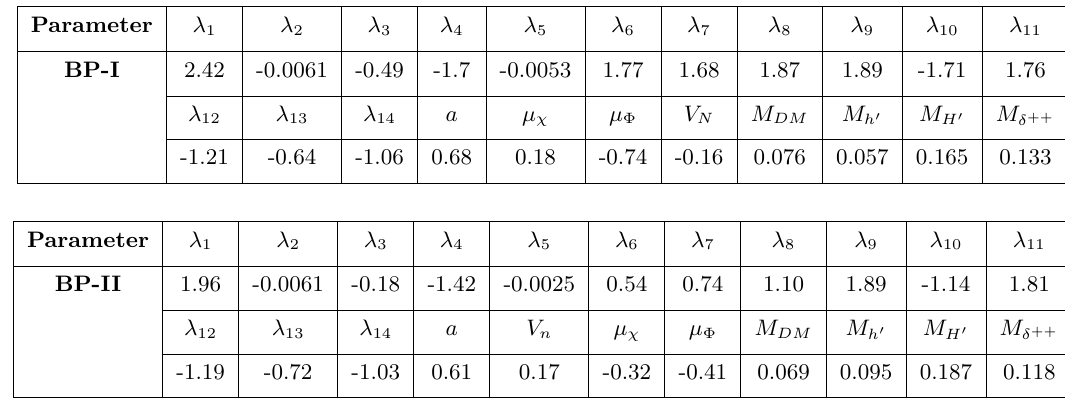
Table 1 . Values of the parameters that satisfies the necessary boundedness conditions defined in eqs. (2.42)–(2.46) and positivity of the square of mass matrices given in appendix A. Here all the mass parameters are in units of the larger VEV V N ’ V ν . Masses of the remaining scalar fields are of order one (in units of V N ) and heavier than M H 0 . Their numerical values are given in appendix A. The state ˜ h is somewhat light and has an intermediate scale mass given by M ˜ the BP-I ( BP-II